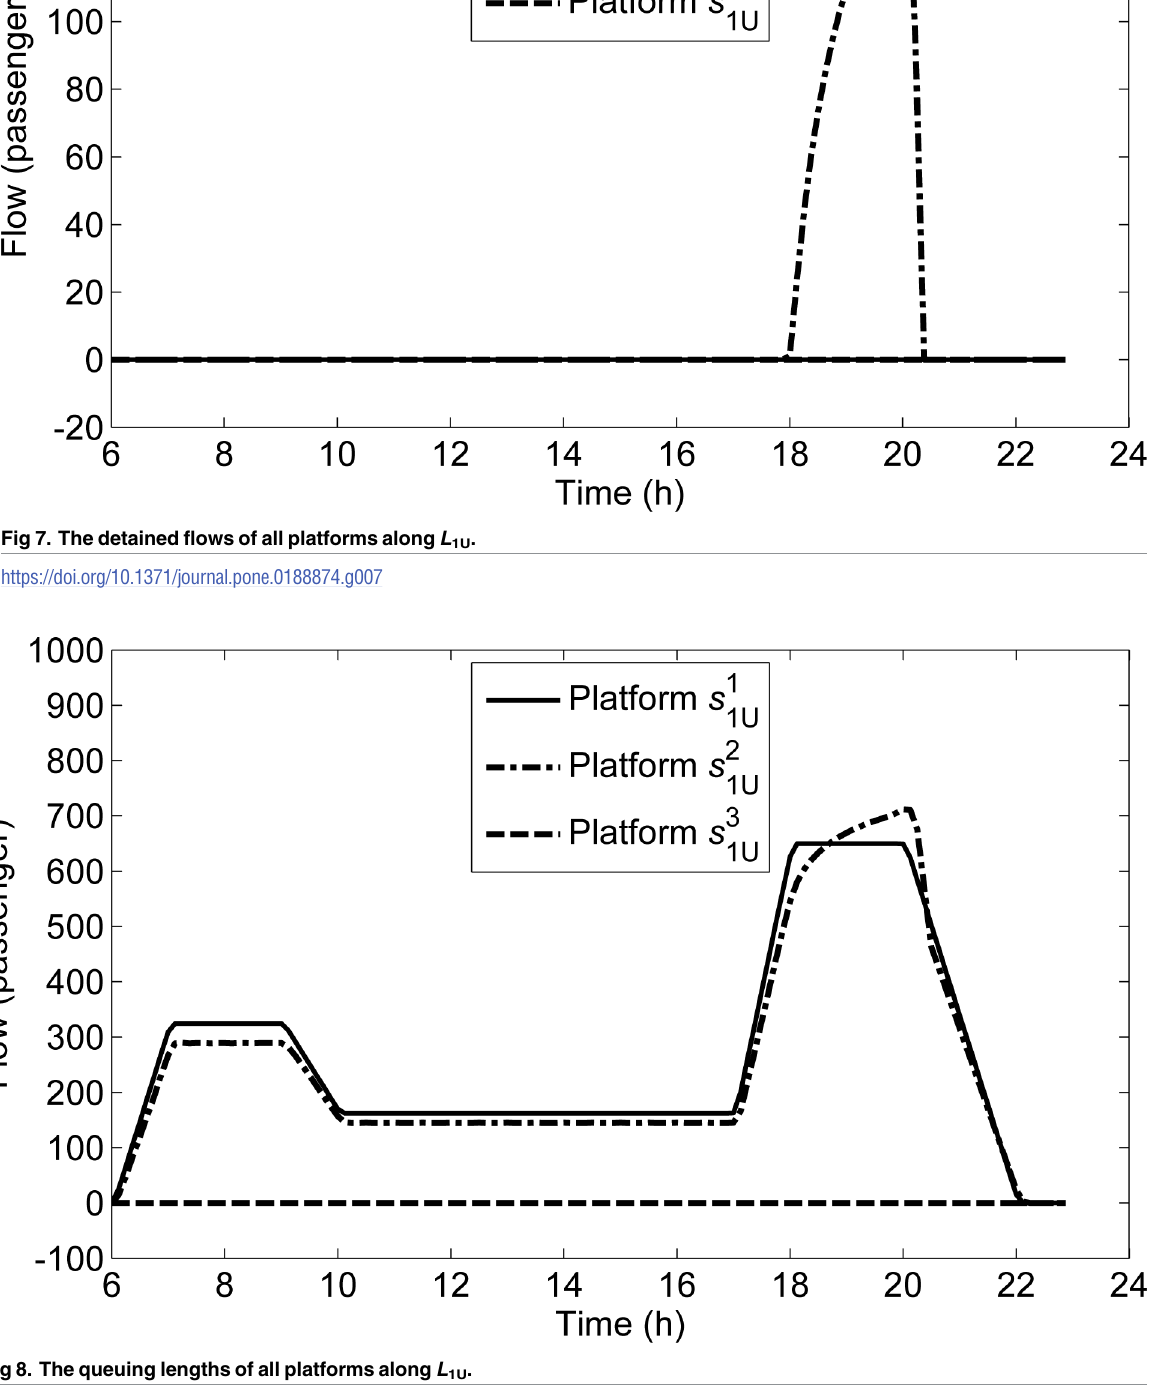
Fig 8. The queuing lengths of all platforms along L 1U .